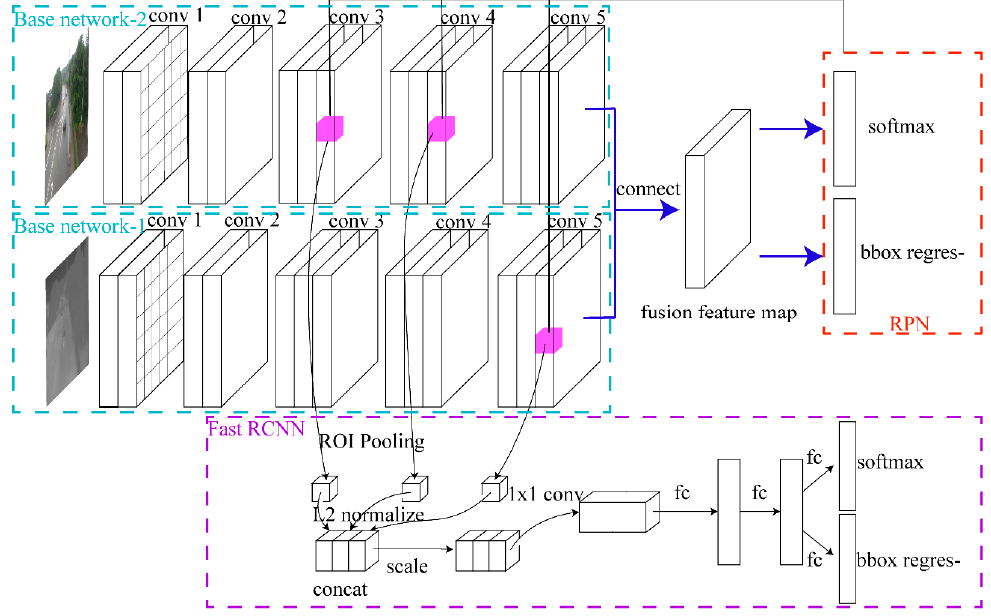
Figure 2. The architecture of dual input faster RCNN (D-F Net). It is a middle level feature fusion model.